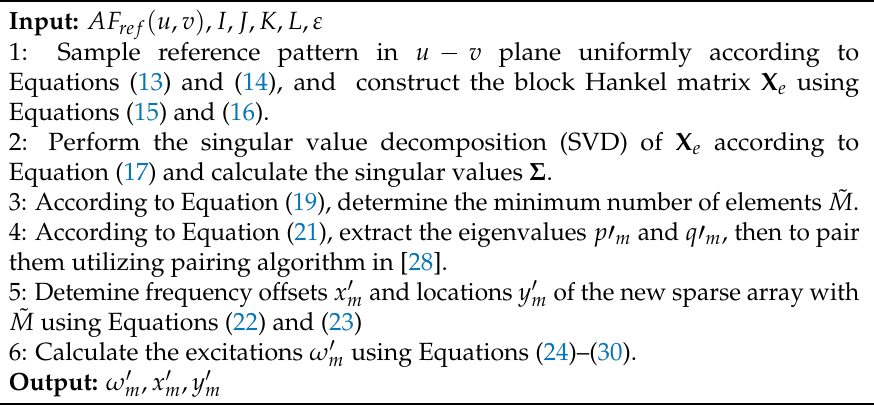
Algorithm 1: Proposed synthesis method for sparse